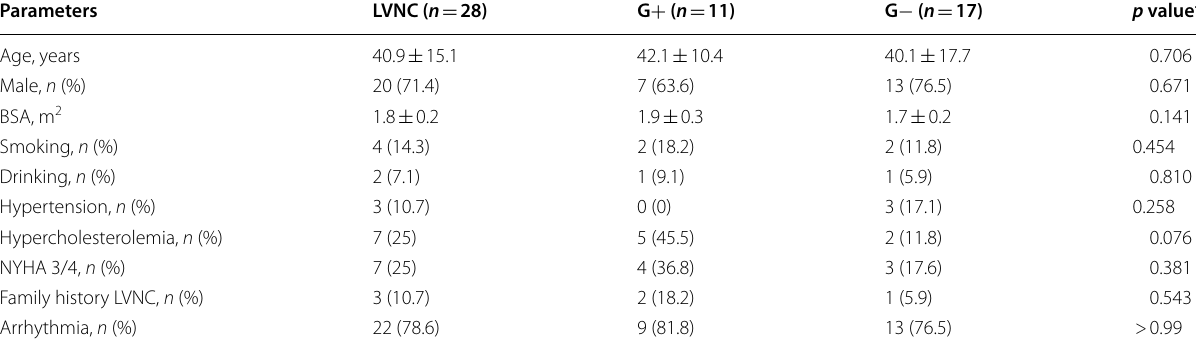
Data are expressed as mean LVNC left ventricular non-compaction cardiomyopathy, G *Significance of difference between parameters from G